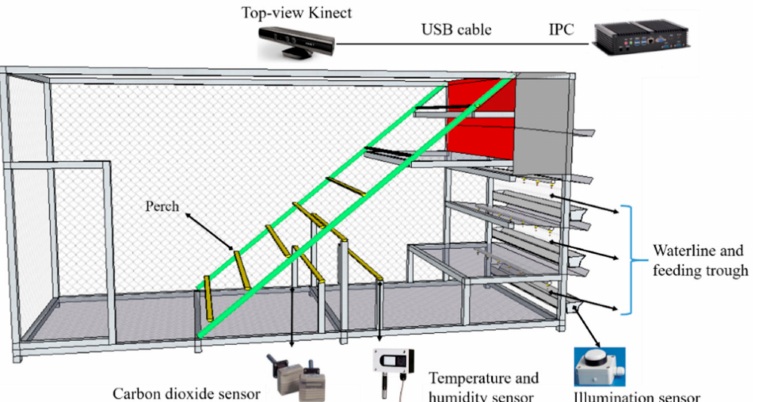
Figure 1. On-site perch husbandry system.